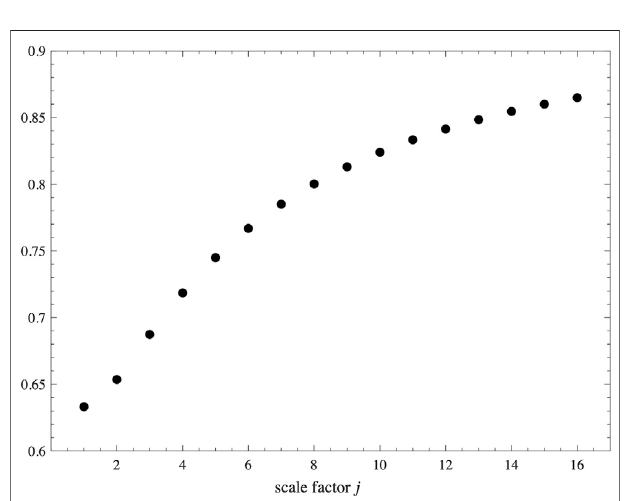
FIGURE 2 | Quantum spread of the cosine of the external dihedral angle of boundary tetrahedra as function of the scale factor.